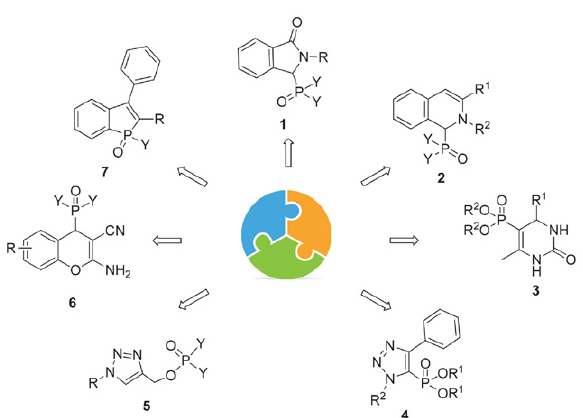
Figure 1. Target molecules